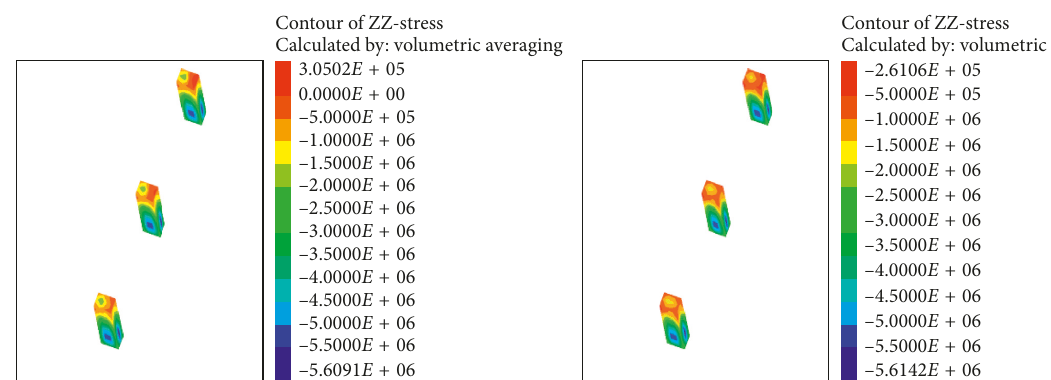
Figure 6: Vertical stress of the pile top. (a) Excavation of 9m. (b) Excavation of 24m.